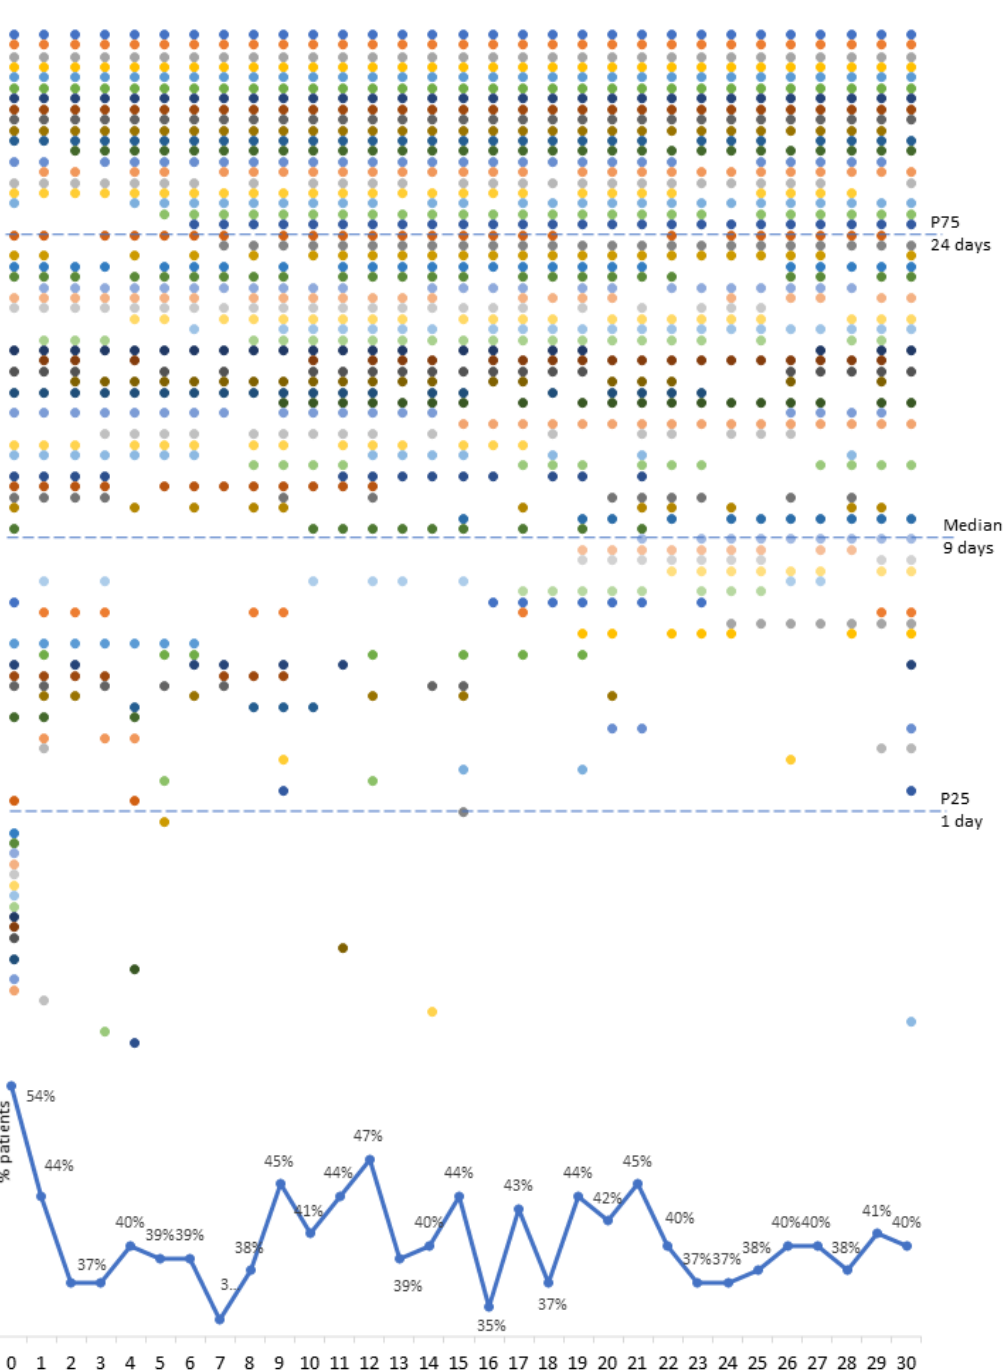
Figure 3. Daily participant engagement with the InspirerMundi app (n=97, 2 users with missing information). Each dot represents a day with interaction, and each color represents a